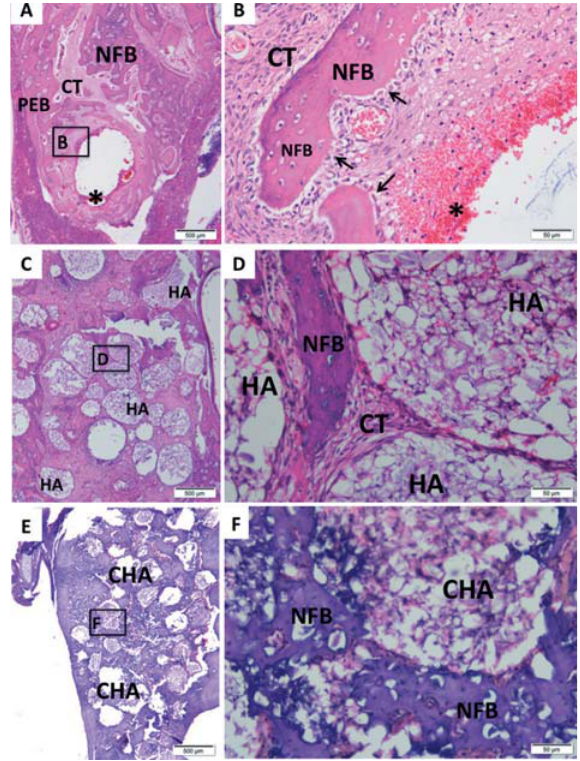
Figure 7- Representative photomicrographs of alveolar Figure 8- Representative photomicrographs of